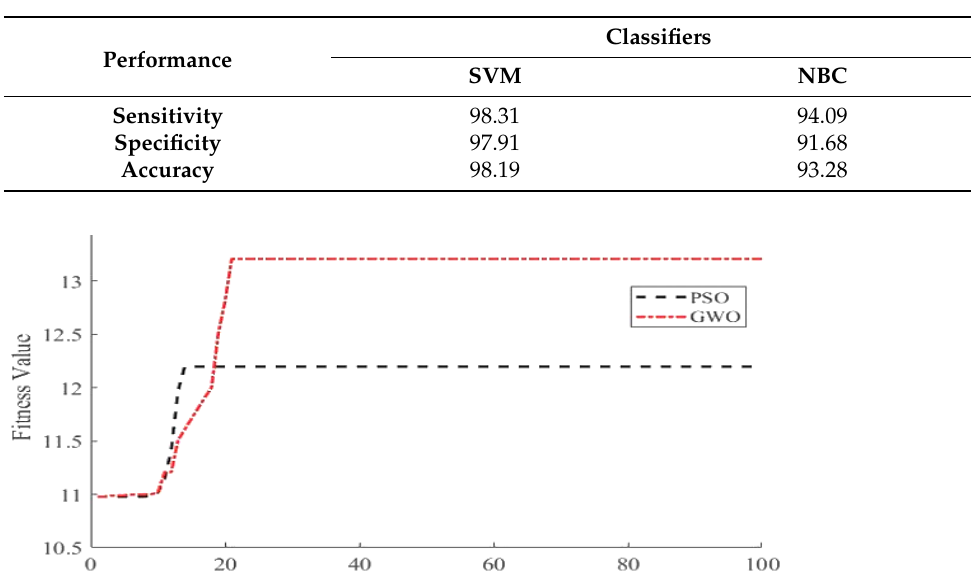
Table 6. Performance of the classifier.